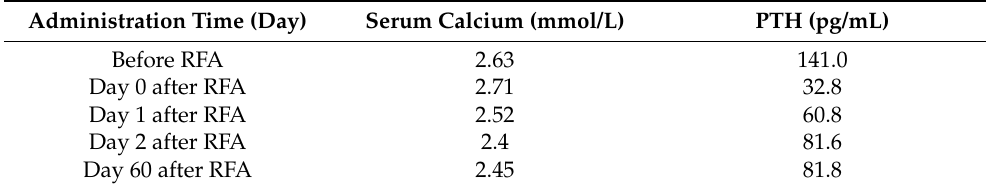
Table 2. The patient’s serum calcium and PTH changes before and after